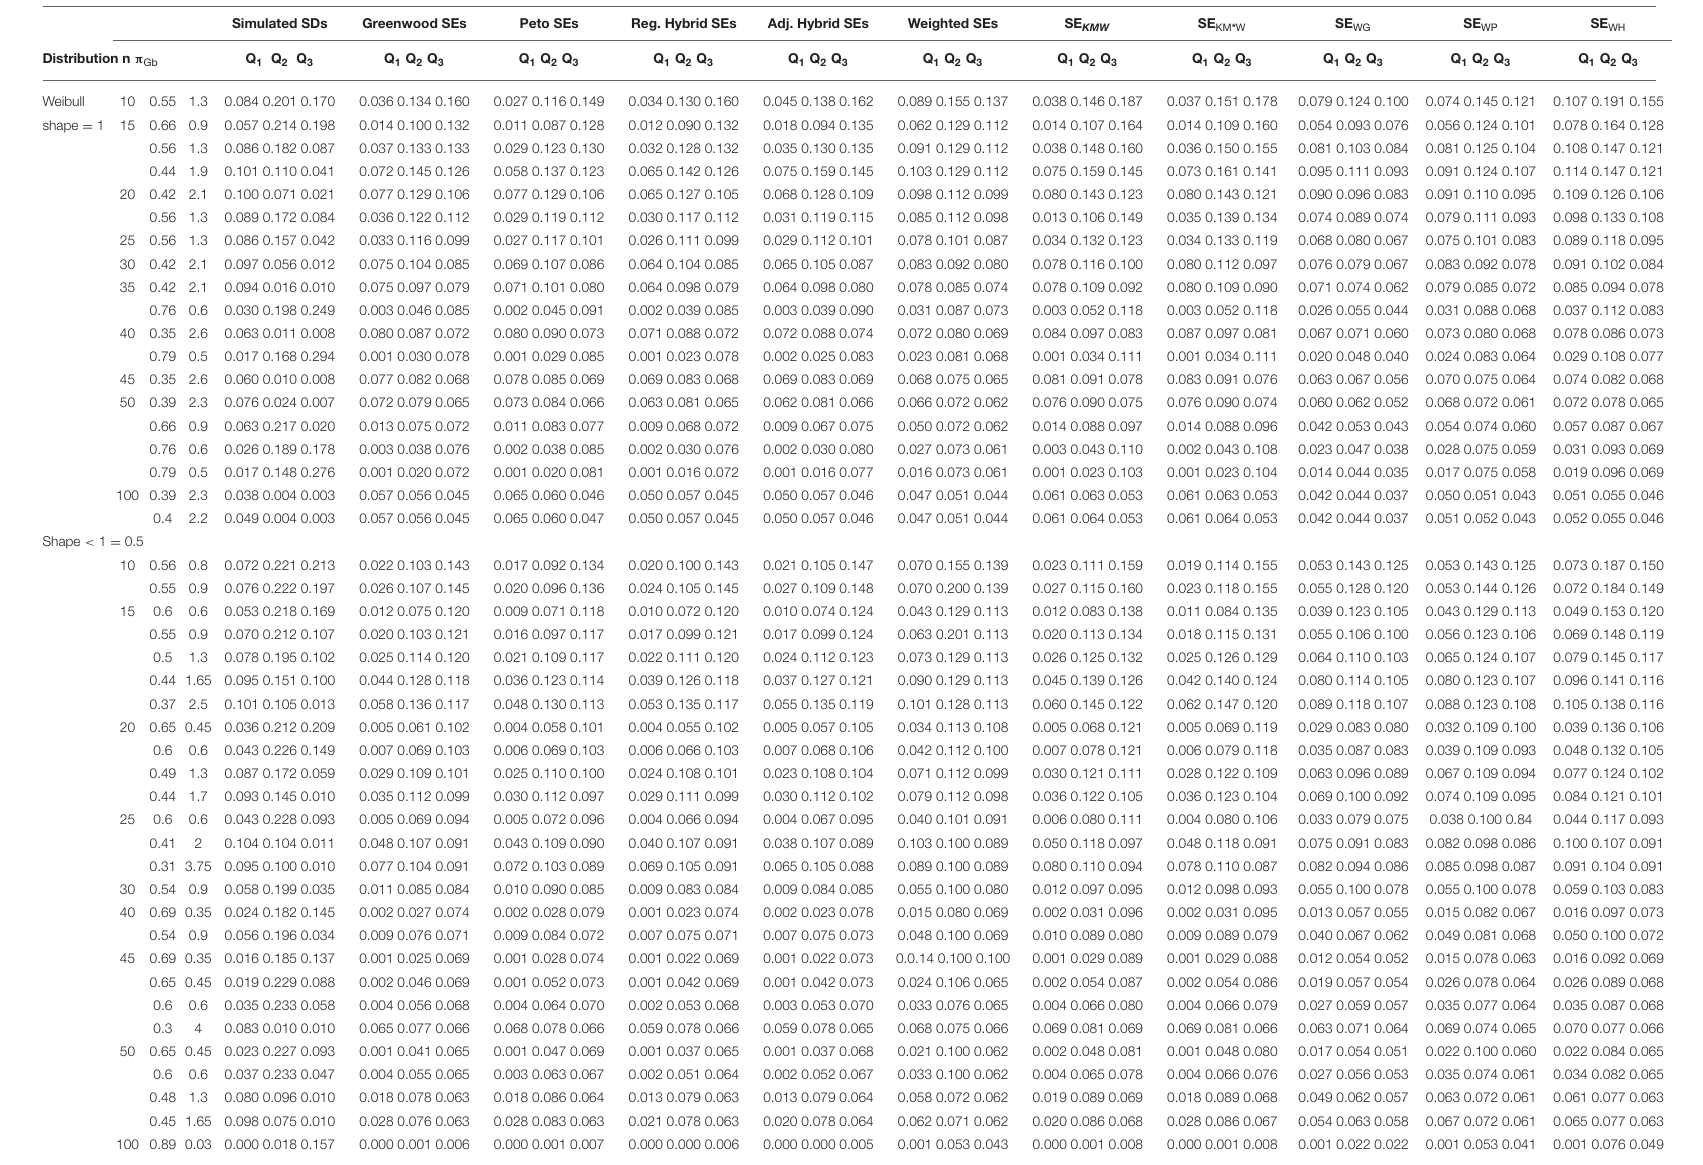
TABLE 1 | Simulated SD s and mean standard errors ( SE s) for ten variance estimators at three quartiles, with data generated from the Weibull and Gamma distribution with different shape parameters and with uniform censoring (based on b), based on 500 simulated trials. Simulated SDs Greenwood